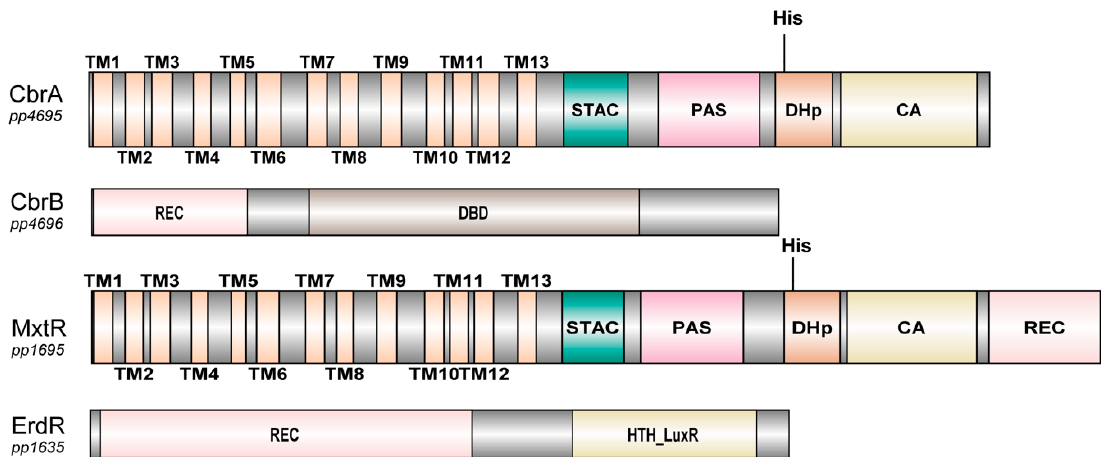
Figure 7. Domain structure of CbrA and MxtR as typical SSS-dependent sensor kinases with the according response regulators. The N-terminal portion of the sensor kinases forms 13 TMDs that resemble the topology of an SSS family member, while the C-terminal portions contains domains typically found in sensor kinases. TM, also called TMD, transmembrane domain; STAC, SLC and TCST-Associated Component; PAS, Per-Arnt-Sim; DHp, histidine phosphotransfer domain, also referred to as HisKA; CA, catalytic ATP-binding domain, also referred to as HATpase_c; REC, receiver; DBD, DNA binding domain (for “sigma-54 interaction domain” predicted by ScanProsite; HTH, helix-turn-helix. Images created with DOG 2.0 illustrator [140]. Domain prediction relies on SMART [113,114] and